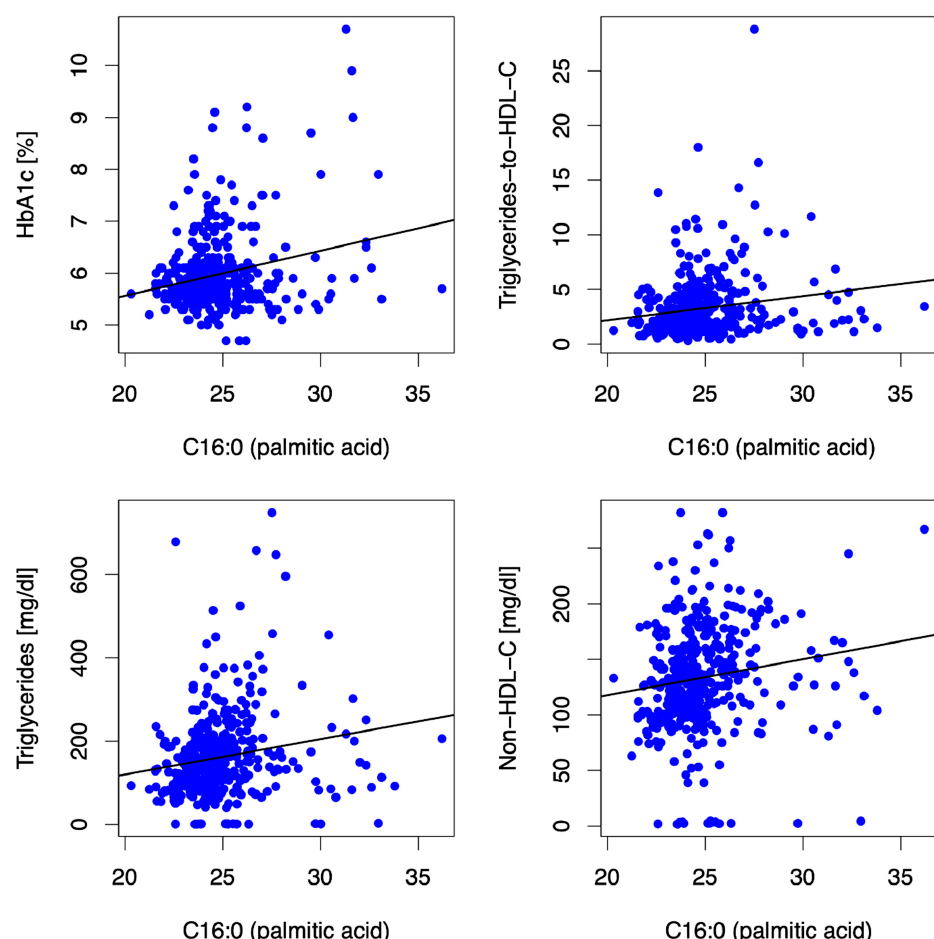
Figure 2. Scatter plots showing correlations between the LCSFA palmitic acid (C16:0) and HbA1c, triglycerides-to-HDL-C ratio, triglycerides, and non-HDL-C at baseline. The SFA palmitic acid (C16:0) was directly associated with HbA1c, triglycerides-to-HDL-C ratio, triglycerides, and non-HDL-C at baseline.